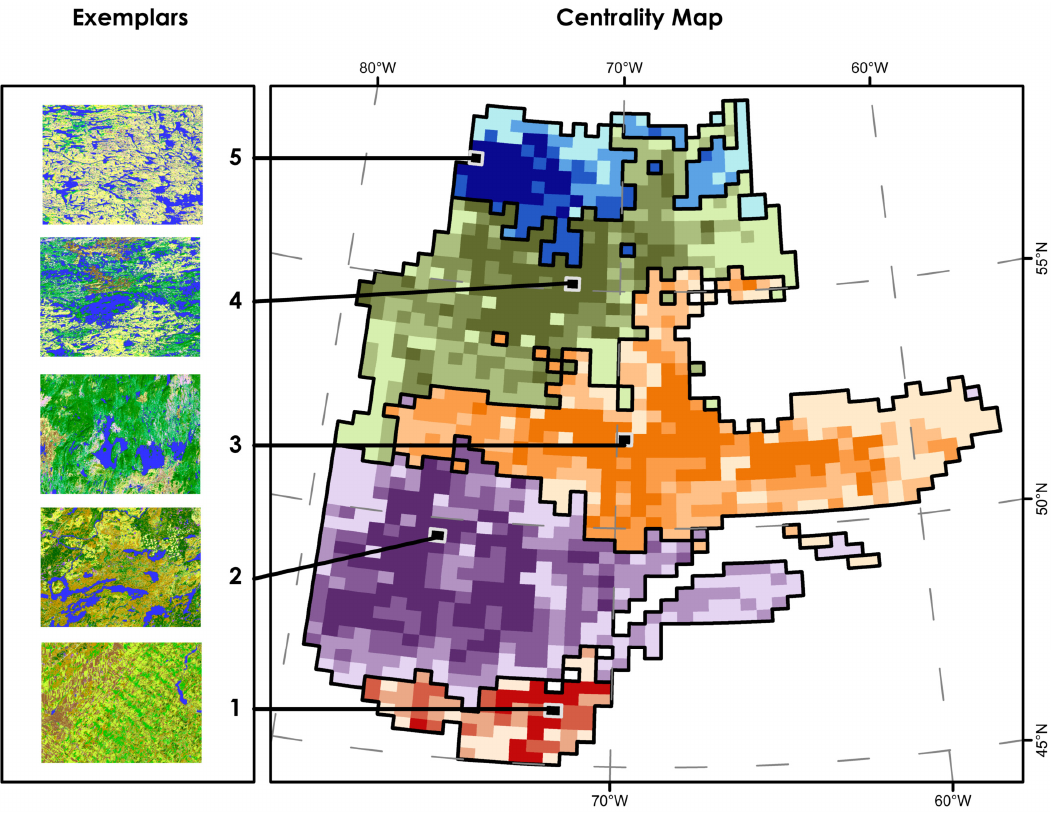
Figure 4. Clustering set of five with representative landscapes located within their clusters in Quebec. In the centrality map, measures of centrality are represented with colour ramps (darker colours represent higher similarity of landscapes to their exemplar, lighter colours represent lower similarity